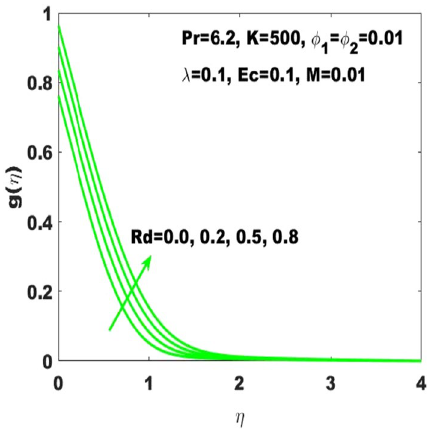
Figure 8. g ( η ) for diverse values of Rd .